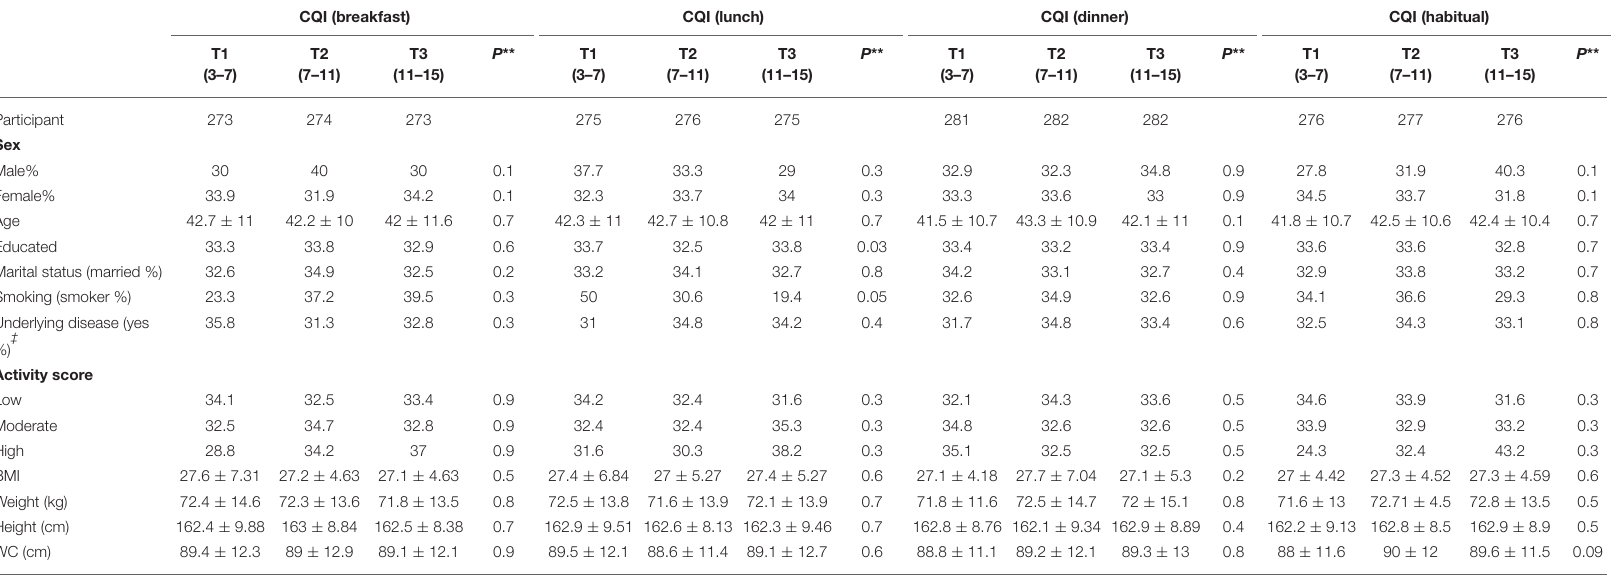
Values are means ± standard deviations (SD) or percentages. Chi-square test used for categorical variables, one-way ANOVA for continuous variables. ** P < 0.05. ‡ Underlying disease: Including diabetes, hypertension, dyslipidemia, cardiovascular disease, stroke, cancer, respiratory disease, and osteoporosis. BMI, body mass index; WC, waist circumference; Kg, kilogram; cm,